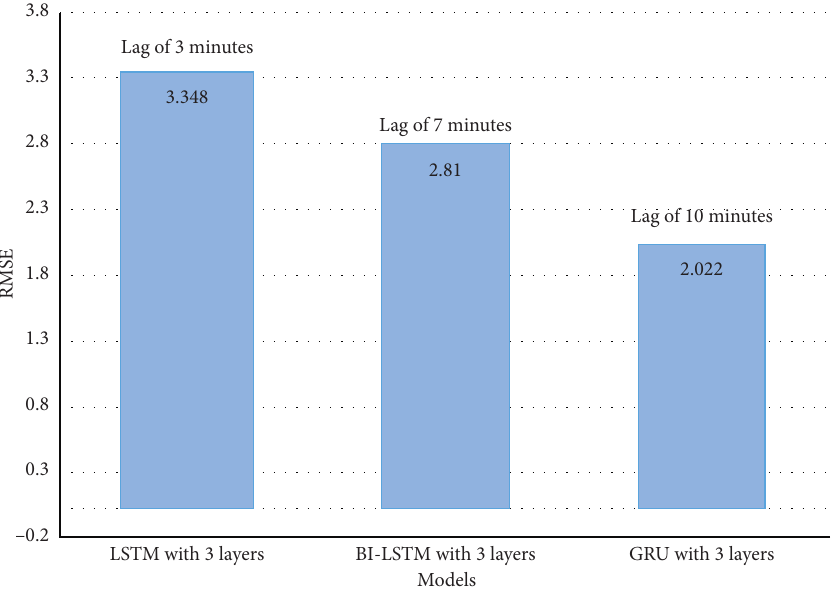
Figure 4: RMSE-based comparison of best prediction Table 5: Generated data samples and their corresponding predicted HR.